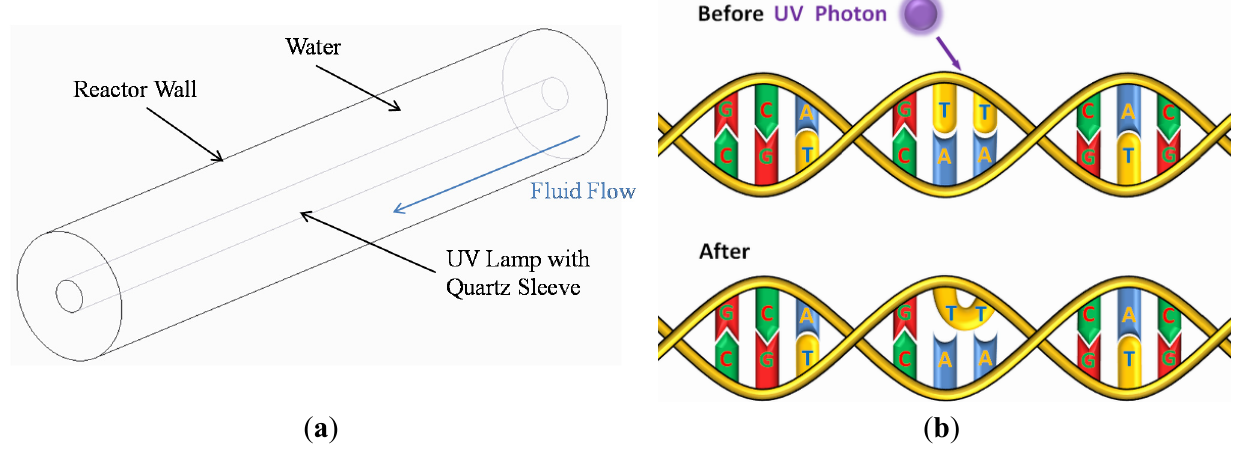
Figure 1. ( a ) Cylindrical UV disinfection closed vessel reactor with mercury vapor lamp; ( b ) formation of thymine dimers by UVC radiation